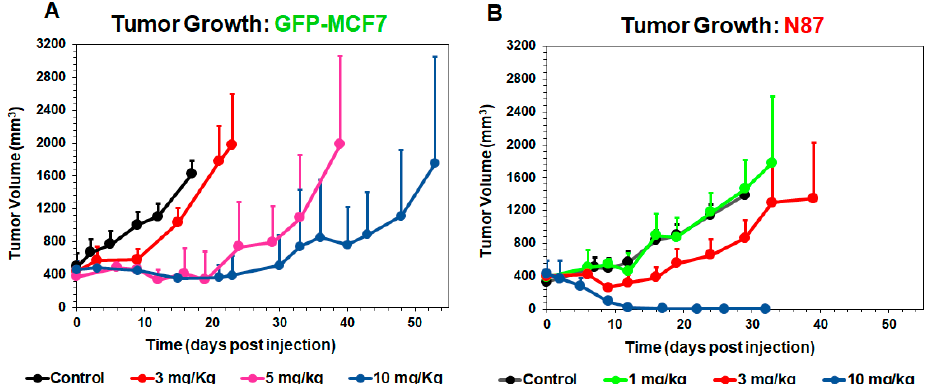
Figure 3. Tumor growth inhibition (TGI) profiles (mean ± standard deviation) in GFP-MCF7 ( A ) and N87 ( B ) tumors of either control (black, n = 7) or after single intravenous administration of T-vc-MMAE at 1 mg/kg (green, n = 7)), 3 mg/kg (red, n = 7), 5 mg/kg (pink, n = 7), and 10 mg/kg (blue, n = 7).